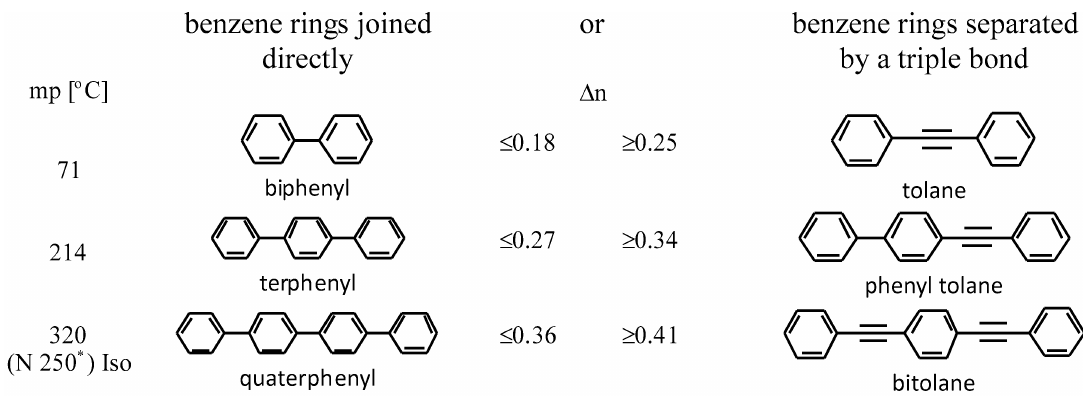
* virtual transition N-Iso = 250 °C was extrapolated from E7